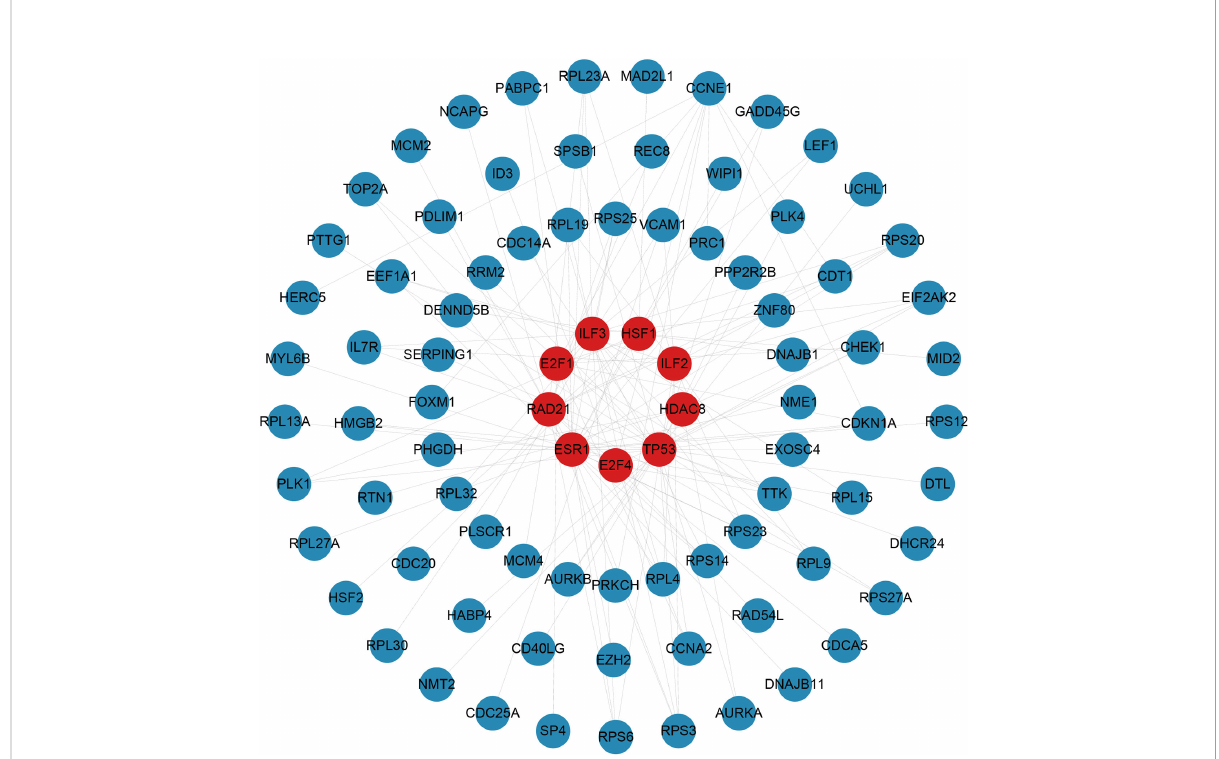
FIGURE 6 The top 10 transcription factors ranked according to their P values and their interactions with common differentially expressed genes. In this network, the red circles represent transcription factors with the top 10 lowest P values in the network, while the blue circles represent common differentially expressed genes correlated with transcription